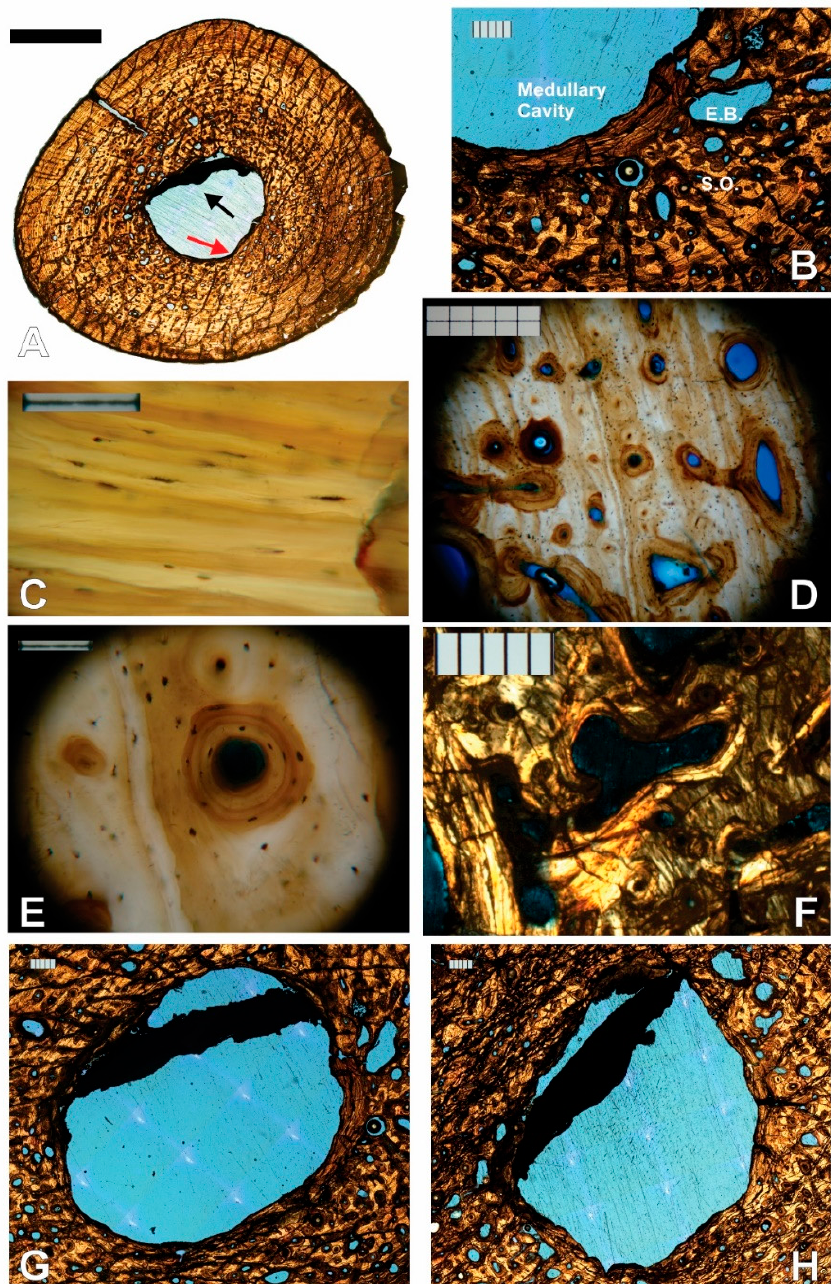
Figure 4. NJSM 23368 left humerus mid-diaphyseal transverse thin-section images. ( A ) Slide 3 of 4, numbered from proximal to distal from the mid diaphysis, under ordinary transmitted light. Top is anterior, right is lateral. Arrows indicate the endosteal, avascular lamellar layer (red) and the structure that divides the medullary cavity (black). Scale bar is 5 mm; ( B ) Close up of endosteal lamellae meeting the deep periosteal cortex in slide 1 under transmitted light. E.B.: Erosion Bay, S.O.: Secondary Osteon. Scale bar is 500 µ m; ( C ) Osteocyte lacunae within the endosteal lamellae that surround the medullary cavity under ordinary transmitted light at 40 × magnification. Orientation of the long axis is generally along the direction of the bone lamellae. Scale bar is 0.1 mm; ( D ) Longitudinally oriented primary and secondary osteons arranged in circular rows under ordinary transmitted light at 10× magnification. Irregularly shaped osteons and osteons with radial anastomoses are also visible. Osteocyte lacunae are fairly dense. Scale bar is 0.5 mm; ( E ) 40× magnification close up of secondary osteon in the middle of D. The long axis of osteocyte lacunae is also oriented in the direction of the bone lamellae within osteons. Scale bar is 0.1 mm; ( F ) Erosion lacuna developing